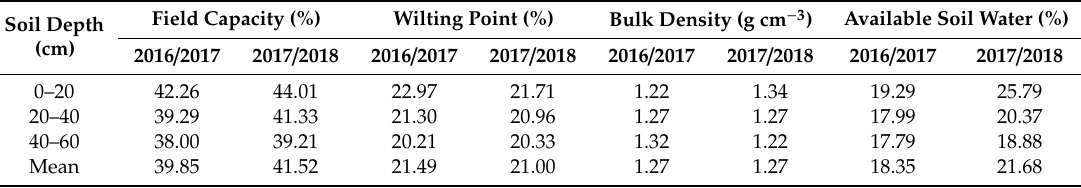
Table 4. The mean values of soil moisture constants of the experimental site before